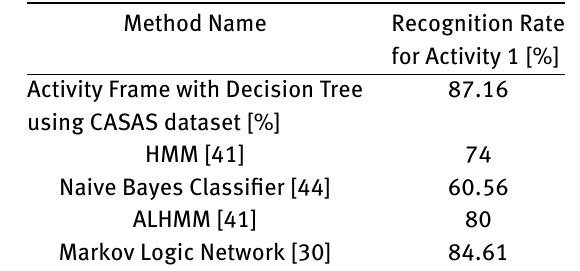
Table 7: Recognition rate using similar methods for the activity make a phone call.